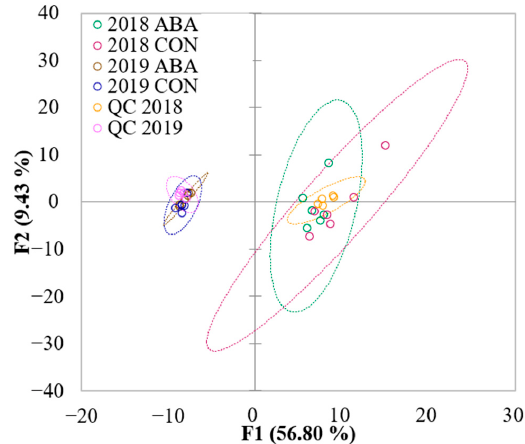
Figure 4. Score plot of principal component analysis with untargeted analysis data obtained with LC-HRMS/MS on wines from GRBV-positive Pinot noir treated with exogenous abscisic acid application (ABA) and no abscisic acid control (CON) across two vintages (QC: quality control samples; n = 6) in Oregon’s Willamette Valley. Dash circles represent 95% confidence interval.